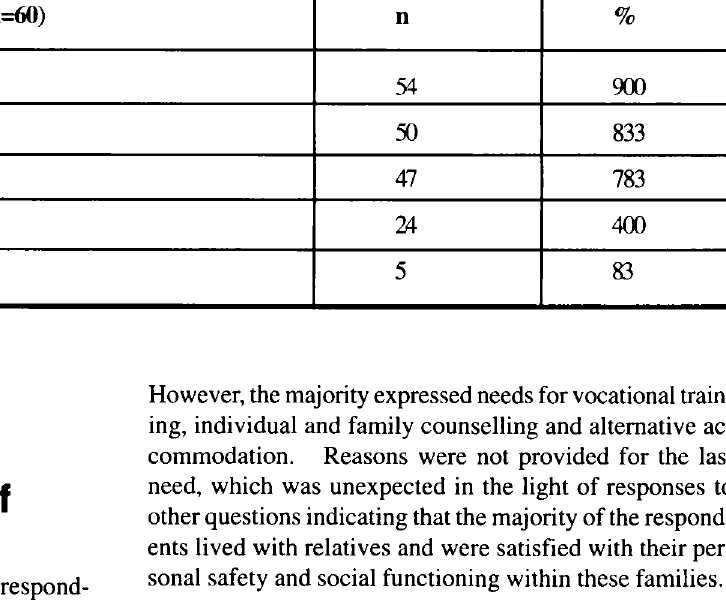
Table 2: Services which the respondents would like to have available in Mogoto Village. SERVICES DESIRED BY RESPONDENTS